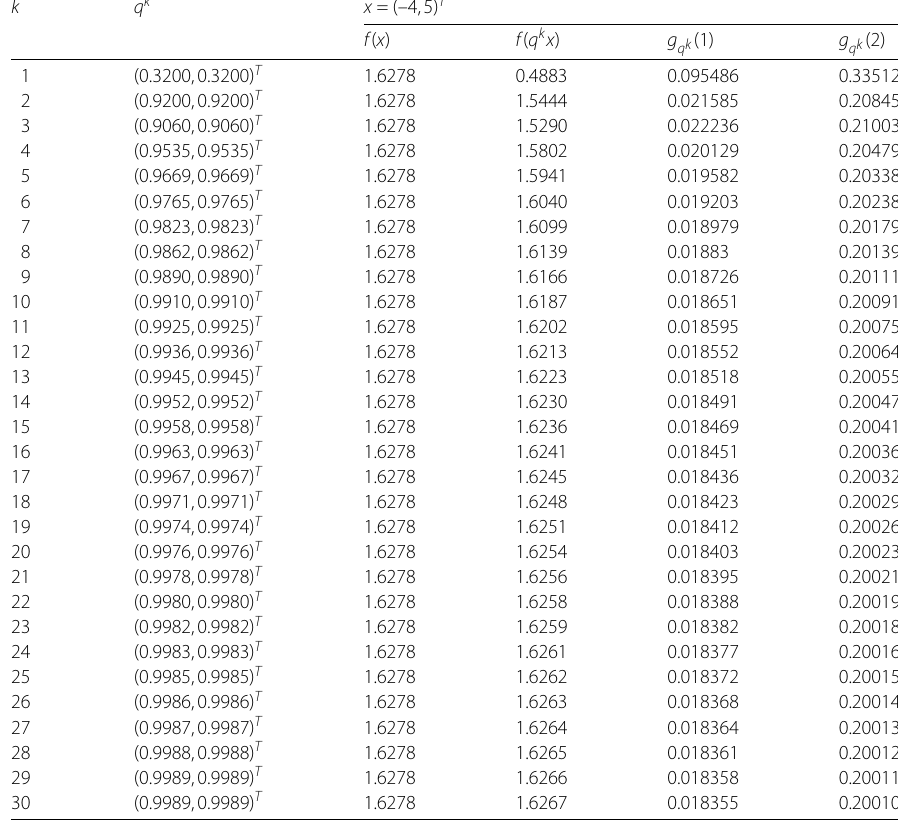
Table 2 Computational details of Example 2 for sequence { q k